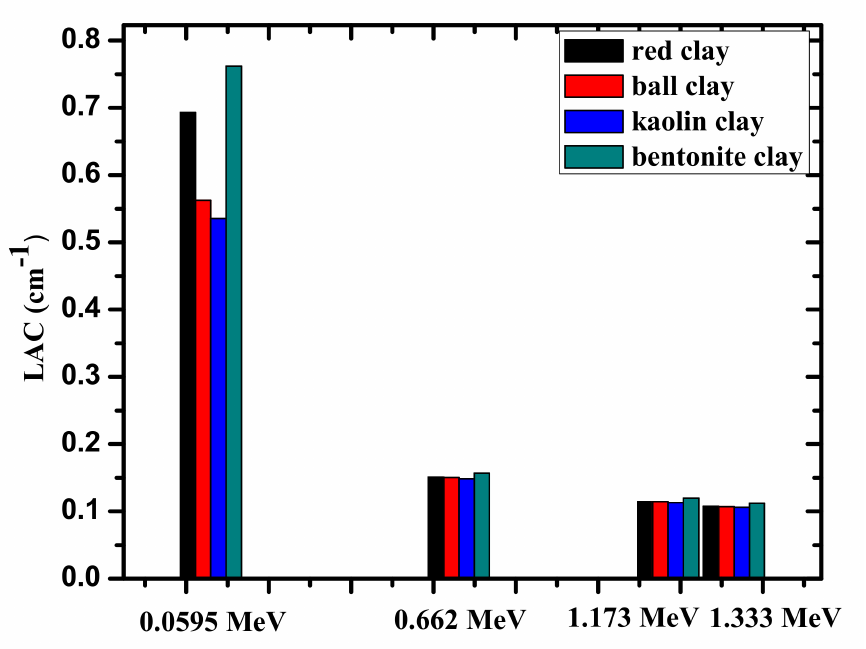
Figure 5. The experimental LAC values for the four investigated clay samples at four selected